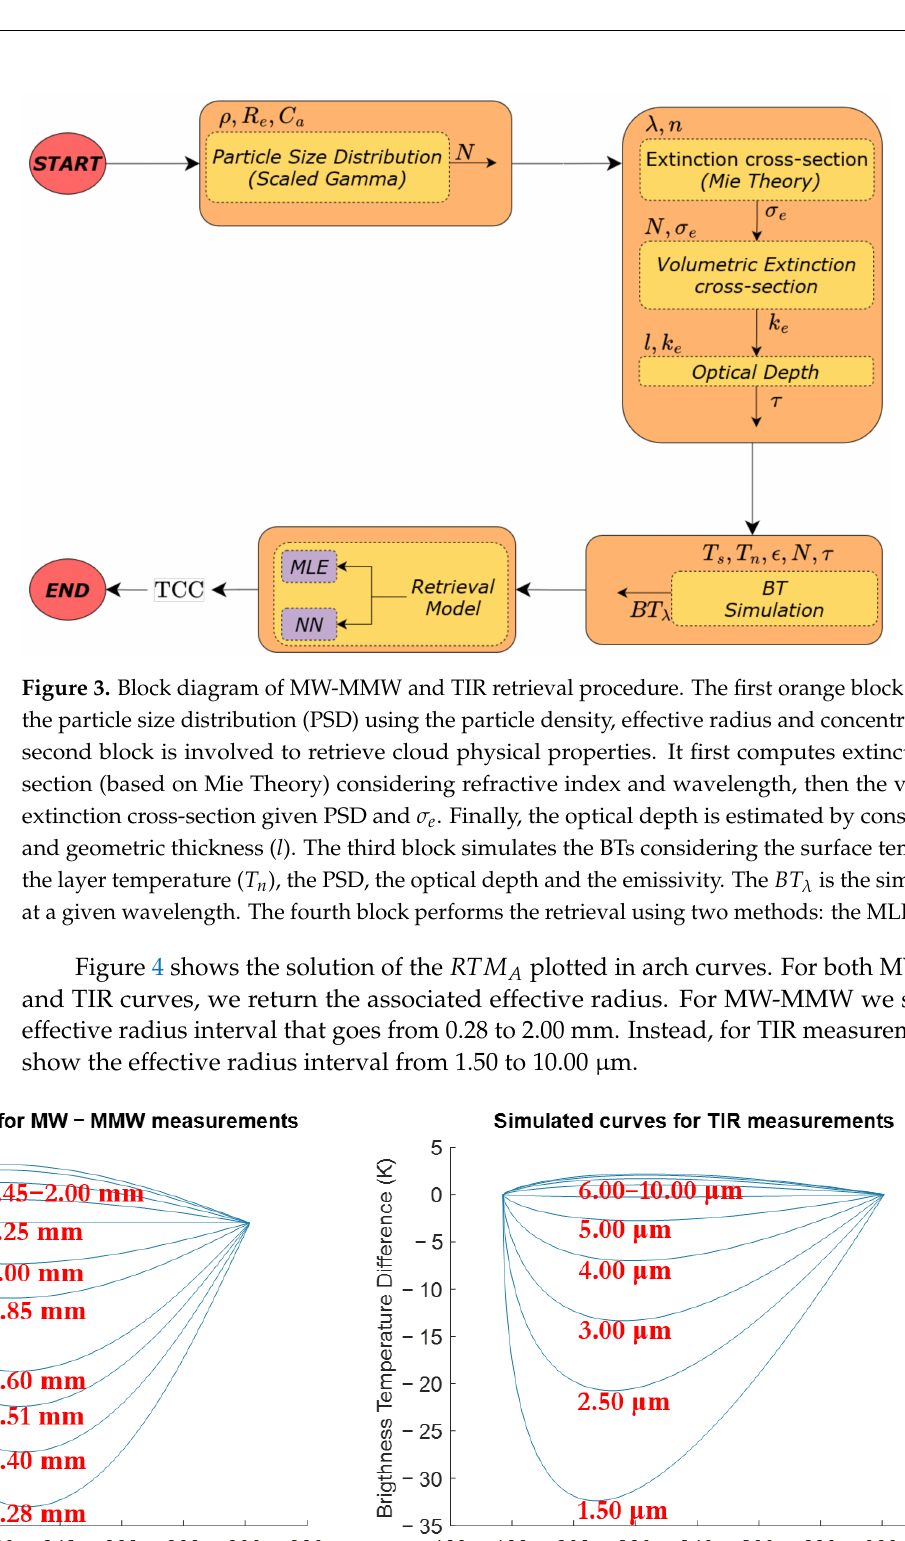
Figure 4. Simulated arch curves for both MW-MMW ( left panel ) and TIR ( right panel ) observations. On the y-axis, respectively, the MSD for MW-MMW and the BTD for TIR. On the x-axis, either the BT at 165.50 GHz or the BT at 10.80 μ m.